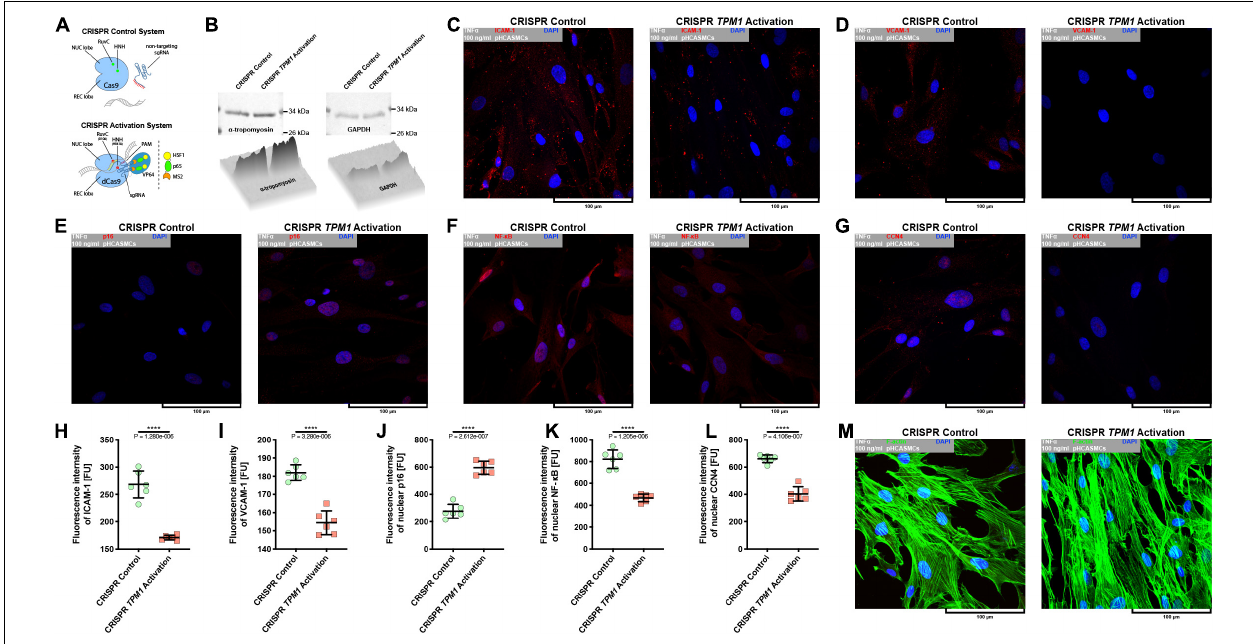
FIGURE 8 | Effect of CRISPR-based activation of endogenous TPM1 expression on expression of molecular markers of TNF α -stimulated pHCASMC migration and proliferation. (A) Schematic overview of CRISPR systems used in regulation of TPM1 expression in pHCASMCs. The cells were nucleofected with CRISPR control plasmid encoding the Cas9 nuclease and a non-specific guide RNA (upper panel) or CRISPR TPM1 activation system encoding the nuclease-deficient dCas9 fused to the transactivation domain VP64, a plasmid encoding the MS2-p65-HSF1 fusion protein, and a guide RNA targeting sequences upstream of TPM1 transcriptional start site (lower panel). (B) Representative western blots and surface plots for α -tropomyosin (left panel) and GAPDH (right panel) in lysates form pHCAECs. (C) Representative confocal micrographs of fluorescently stained ICAM-1. Double fluorescent staining for ICAM-1 (red) and DNA (blue) was performed after fixation of TNF α -stimulated pHCASMCs nucleofected with CRISPR control (left panel) or CRISPR TPM1 activation systems (right panel). TNF α 100 ng/ml to cells treated with rh TNF α . (D) Representative confocal micrographs of fluorescently stained VCAM-1. Double fluorescent staining for VCAM-1 (red) and DNA (blue) was performed after fixation of TNF α -stimulated pHCASMCs nucleofected with CRISPR control (left panel) or CRISPR TPM1 activation systems (right panel). TNF α 100 ng/ml refers to cells treated with rh TNF α . (E) Representative confocal micrographs of fluorescently stained p16. Double fluorescent staining for p16 (red) and DNA (blue) was performed after fixation of TNF α -stimulated pHCASMCs nucleofected with CRISPR control (left panel) or CRISPR TPM1 activation systems (right panel). TNF α 100 ng/ml refers to cells treated with rh TNF α . (F) Representative confocal micrographs of fluorescently stained NF κ B. Double fluorescent staining for NF κ B (red) and DNA (blue) was performed after fixation of TNF α -stimulated pHCASMCs nucleofected with CRISPR control (left panel) or CRISPR TPM1 activation systems (right panel). TNF α 100 ng/ml refers to cells treated with rh TNF α . (G) Representative confocal micrographs of fluorescently stained CCN4. Double fluorescent staining for CCN4 (red) and DNA (blue) was performed after fixation of TNF α -stimulated pHCASMCs nucleofected with CRISPR control (left panel) or CRISPR TPM1 activation systems (right panel). TNF α 100 ng/ml refers to cells treated with rh TNF α . (H) Fluorescence intensity of ICAM-1 measured in TNF α -stimulated pHCASMCs nucleofected with CRISPR control or CRISPR TPM1 activation systems. **** refers to p < 0.0001 as determined by unpaired t -test. (I) Fluorescence intensity of VCAM-1 measured in TNF α -stimulated pHCASMCs nucleofected with CRISPR control or CRISPR TPM1 activation systems. **** refers to p < 0.0001 as determined by unpaired t -test. (J) Fluorescence intensity of p16 measured in nuclei of TNF α -stimulated pHCASMCs nucleofected with CRISPR control or CRISPR TPM1 activation systems. **** refers to p < 0.0001 as determined by unpaired t -test. (K) Fluorescence intensity of NF κ B measured in nuclei of TNF α -stimulated pHCASMCs nucleofected with CRISPR control or CRISPR TPM1 activation systems. **** refers to p < 0.0001 as determined by unpaired t -test. (L) Fluorescence intensity of CCN4 measured in nuclei of TNF α -stimulated pHCASMCs nucleofected with CRISPR control or CRISPR TPM1 activation systems. **** refers to p < 0.0001 as determined by unpaired t -test. (M) Representative confocal micrographs of fluorescently stained F-actin. Double fluorescent staining for F-actin (green) and DNA (blue) was performed after fixation of TNF α -stimulated pHCASMCs nucleofected with CRISPR control (left panel) or CRISPR TPM1 activation systems (right panel). TNF α 100 ng/ml refers to cells treated with rh TNF α